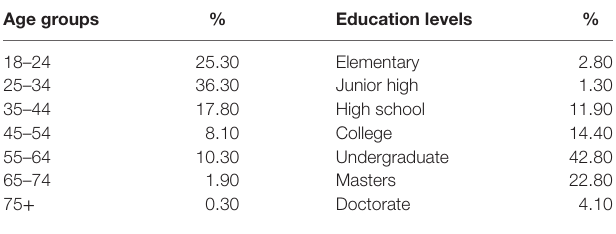
Table 1 | Percentages of each age group and education